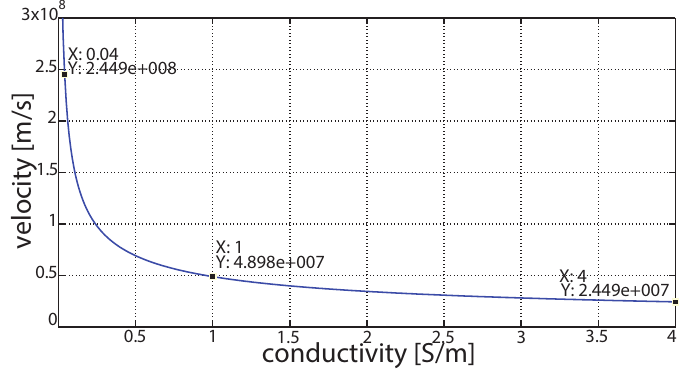
Figure 7. Velocity of EM waves at different conductivities of